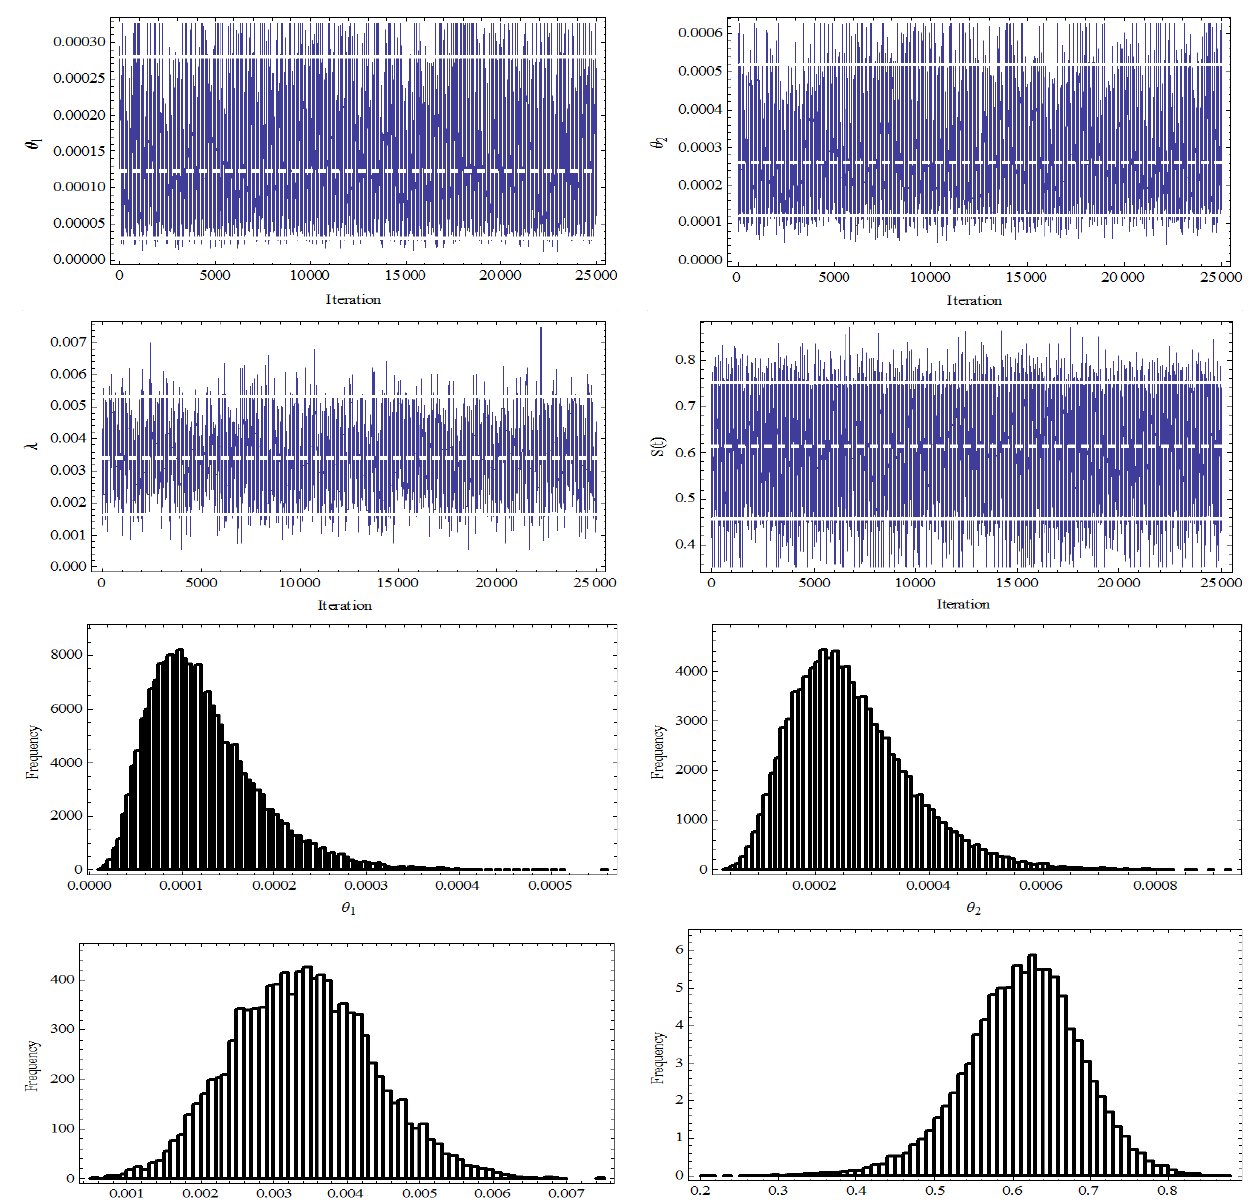
Figure 5. MCMC trace plot (first row) and Histogram (second row) of θ 1 , θ 2 λ , and S ( t ) for Hoel Fig. 5: MCMC trace plot ((cid:133)rst row) and Histogram (second row) of (cid:18) 1 ; (cid:18) 2 (cid:21) , and S ( t ) for Hoel (1972) data. Dashed lines ( ... ) (1972) data. Dashed lines ( ...) represent the posterior means and soled lines (—) represent lower, represent the posterior means and soled lines ((cid:151) ) represent lower, and upper bounds 95% probability interval. and upper bounds 95% probability